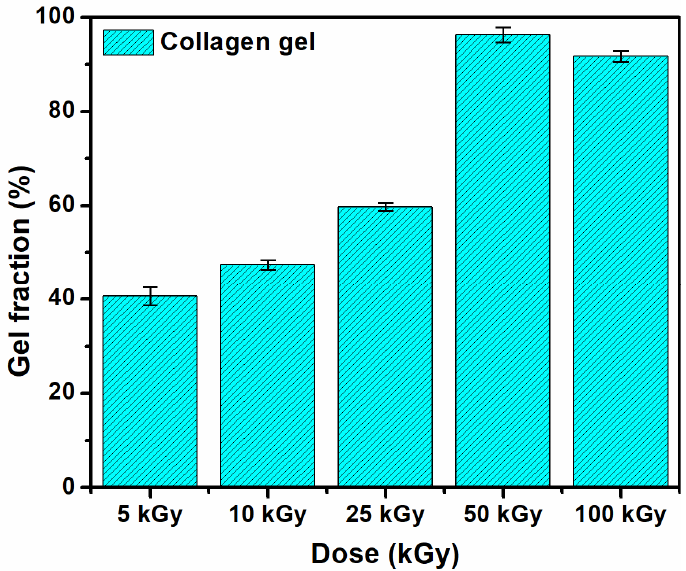
Figure 1. Gel fraction of e ‐ beam crosslinked collagen hydrogels.